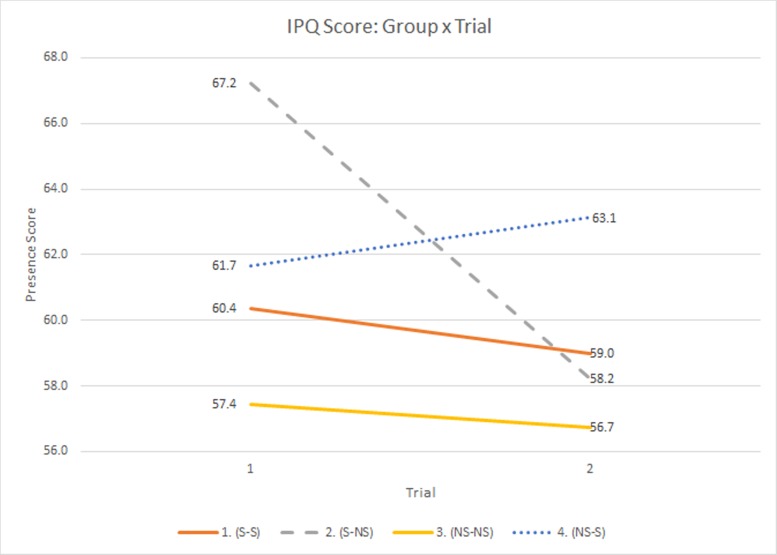
IPQ Scores by Trial.